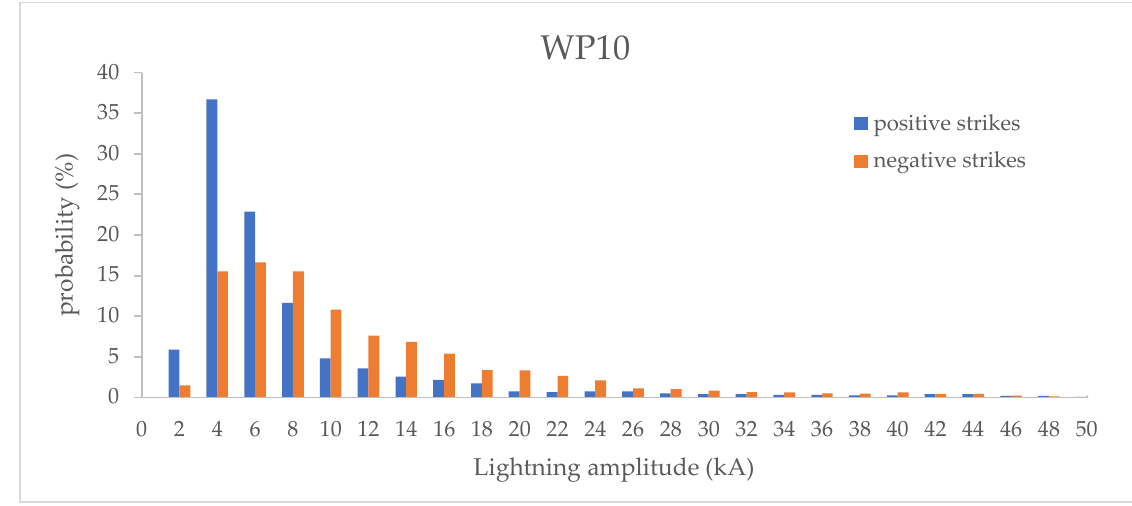
Figure A9. Lightning current amplitude probability distributions for positive and negative strikes extracted from the rec- orded incidents throughout the period 2011–2020 for WP9.